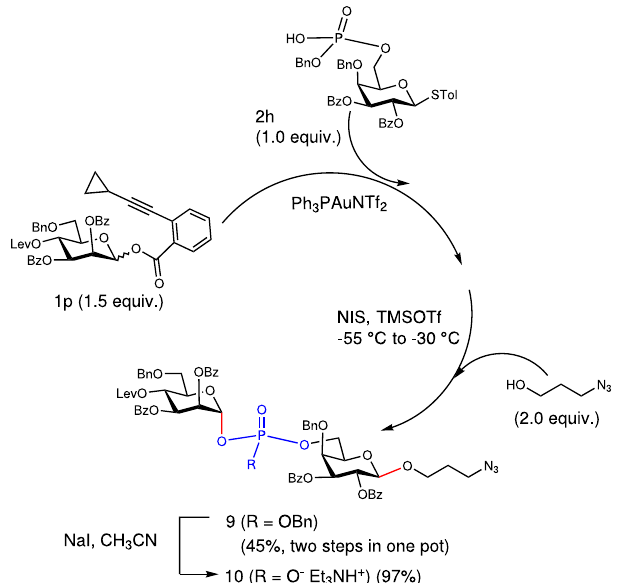
Fig. 7 One-pot synthesis of GPS 9. NIS: N -iodosuccinimide. Tol: tolyl. Lev: levulinoyl. Bn: benzyl. Bz: benzoyl. TMSOTf: trimethylsilyl tri fl uoromethanesulfonate. In red are the formed glycosidic bonds. In blue is the phosphate moiety in product.